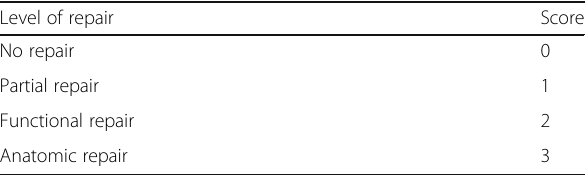
Table 1 Scoring system for level of repair Level of repair